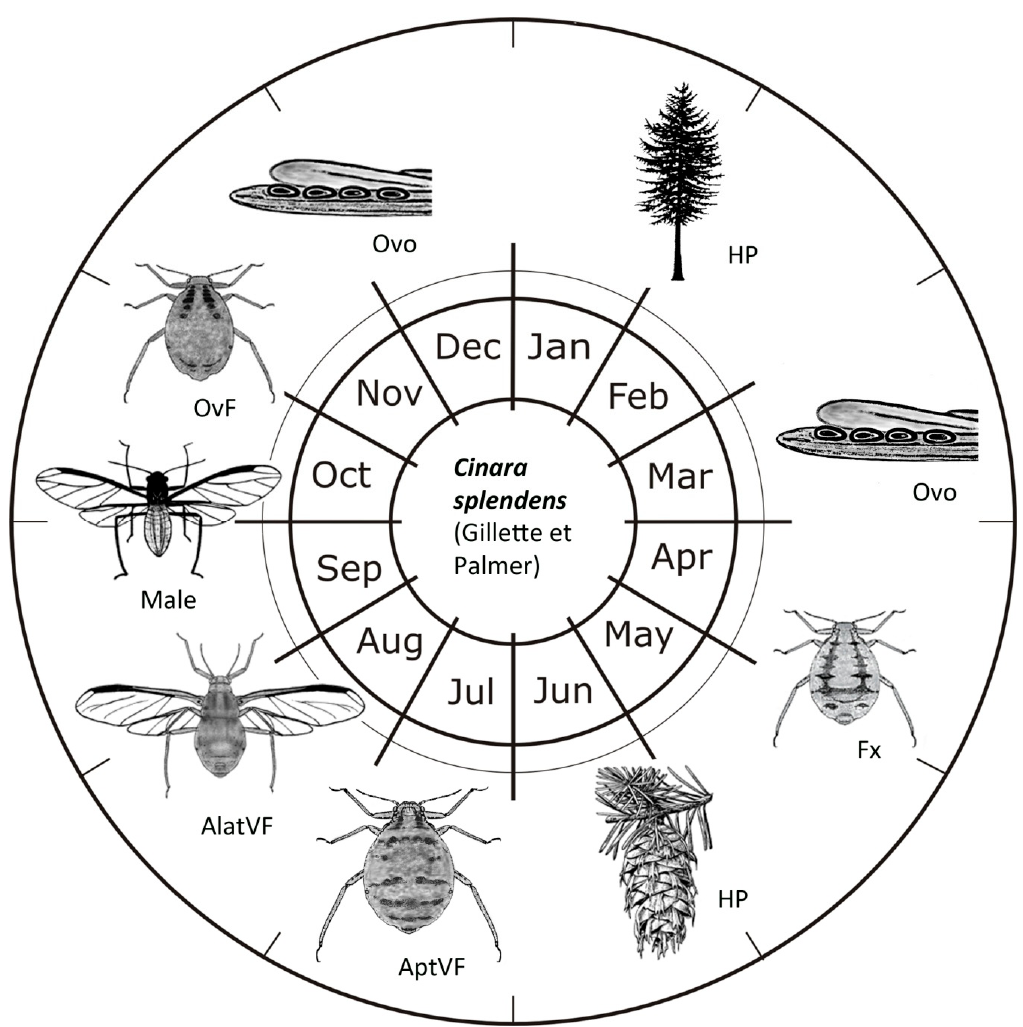
Figure 3. Cinara splendens (Gillette and Palmer, 1924) life-cycle in Central Europe. (HP = host plant; Fx = fundatrix; AptVF = apterous viviparous female; AlatVF = Alate viviparous female; OvF = ovipara). Morphology-based identification was confirmed by the analysis of two DNA fragments, mitochondrial COI and nuclear EF-1 α , of the collected samples. Additional partial sequences of COI ( n = 29) and EF-1 α ( n = 27) genes were downloaded from GenBank for comparison (Table 2). Neighbor-joining (NJ) trees for both fragments were constructed to examine the position of the Cinara sample collected on Pseudotsuga in the Czech Republic among available di ff erent taxa of Cinara, feeding on the same host plant. In both cases, the sample from the Czech Republic clustered together with partial COI or EF-1 α sequences obtained from samples identified as C. splendens . The most similar COI haplotype to that detected in the Czech Republic was from the sample collected in Washington (USA). In the case of the EF-1 α fragment, the closest sequence was that originating from Oregon (USA). NJ trees are presented in Figures 4 and